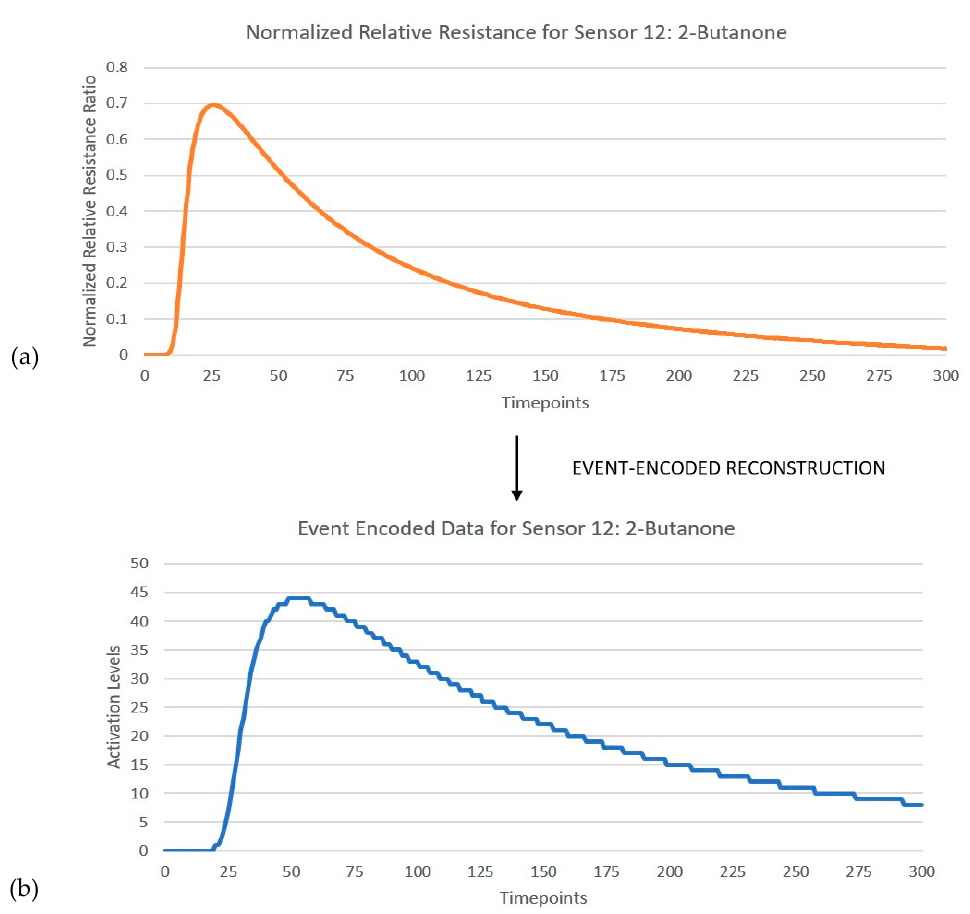
( b ) Encoding of the feature extracted curve into 6-bit activation levels.